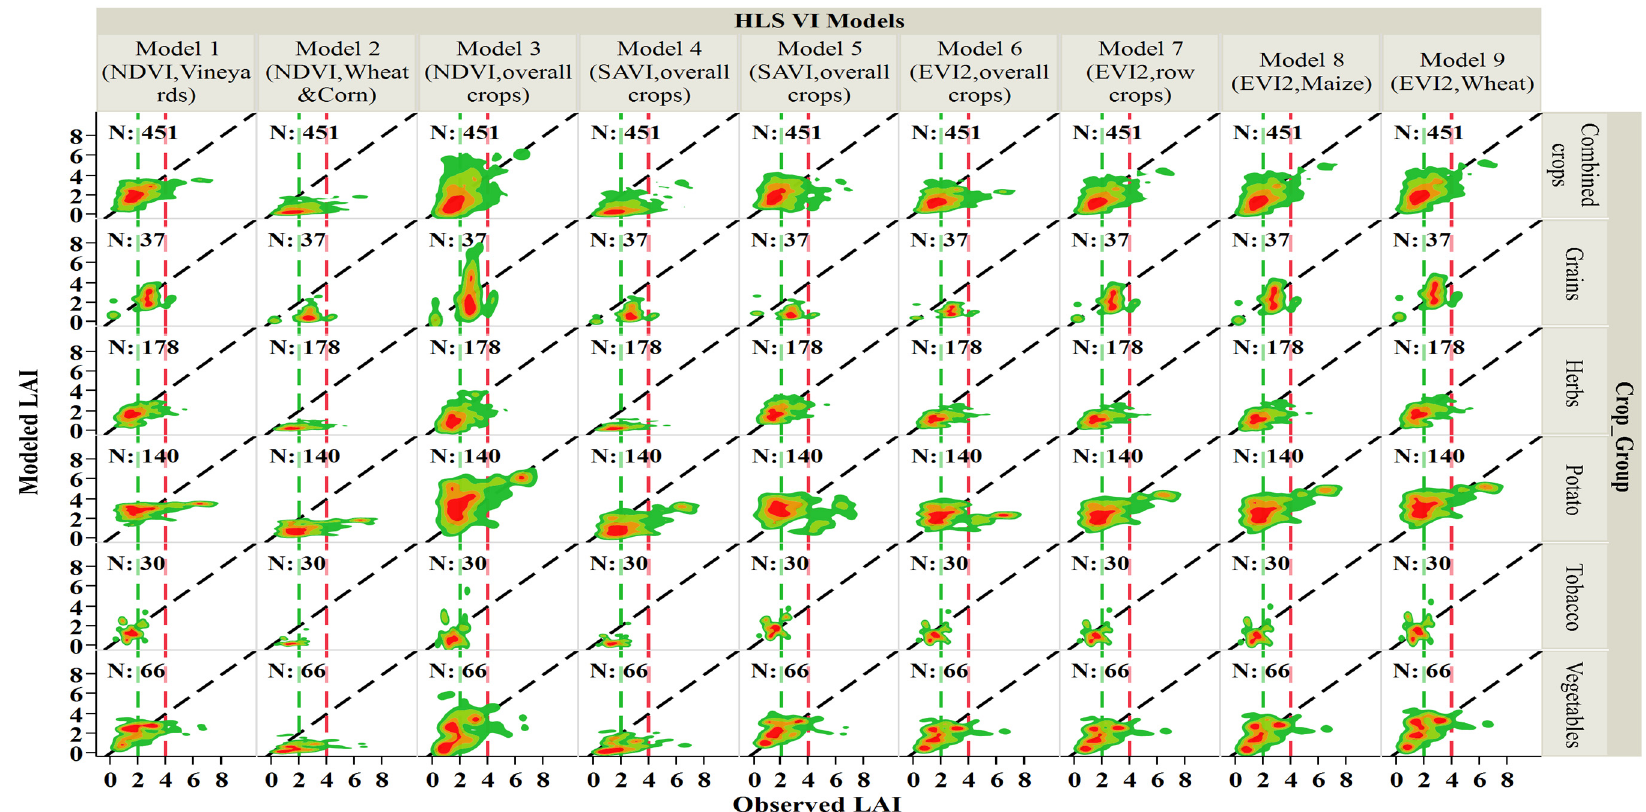
Figure 7 . Comparison between modeled and observed LAI in the 2018–2019 growing seasons for the HLS ‐ VI models. The dashed green vertical lines represent the low observed LAI interval (0–2 m 2 /m 2 ), the dashed red vertical lines represent the high observed LAI interval (>4 m 2 /m 2 ), and the region between these two vertical lines represents the medium observed LAI range (2–4 m 2 /m 2 ), the 2 ‐ D density plots represent four color levels with a dark red color at high density to dark green at lower densities, in addition to the orange and light green in representing medium densities.